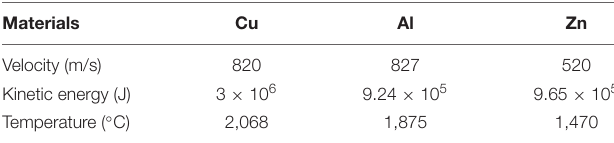
Frontiers in Materials |